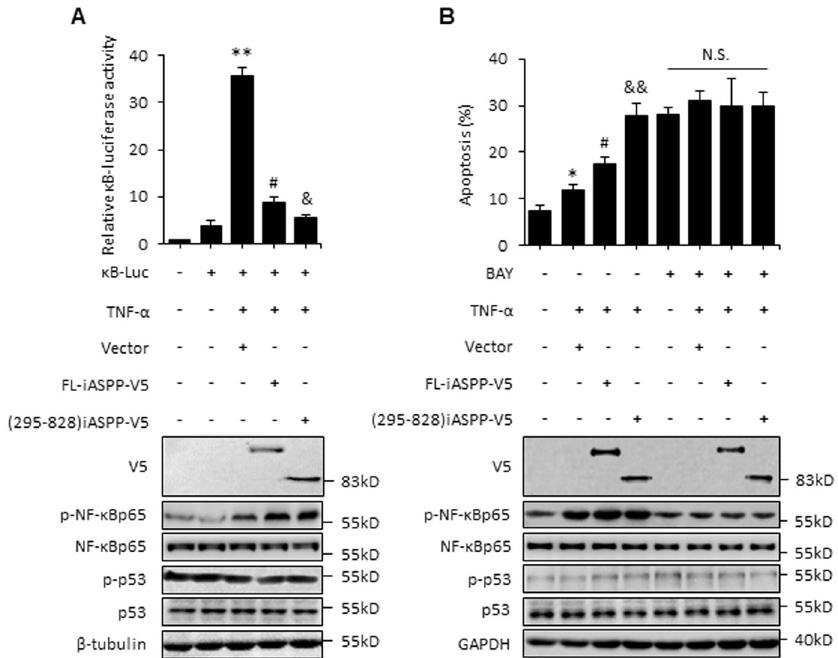
Fig. 2 iASPP fragment promotes apoptosis in MCF-7 when NF- κ Bp65 was activated by TNF- α . MCF-7 cells were transfected as indicated and treated with or without 10 nM TNF- α in the presence or absence of 10 μ M BAY117082 (BAY), then the transcriptional activity of NF- κ Bp65, as indicated by κ B luciferase activity ( A ) or apoptosis levels ( B ), were measured. The κ B luciferase activity in cells transfected with the same amount of empty vector plasmid was normalized to 1. Relative protein levels were determined by western blot. β -tubulin was used as an immunoblots loading control. * p < 0.05,** p < 0.01, relative to the untreated control; # p < 0.05 relative to the TNF- α -treated control; & p < 0.05, && p < 0.01 relative to TNF- α -treated FL control. N.S. not signi fi